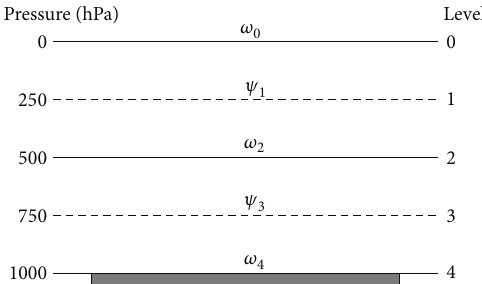
Figure 1: The distribution of levels and arrangement of variables in the vertical for two-layer